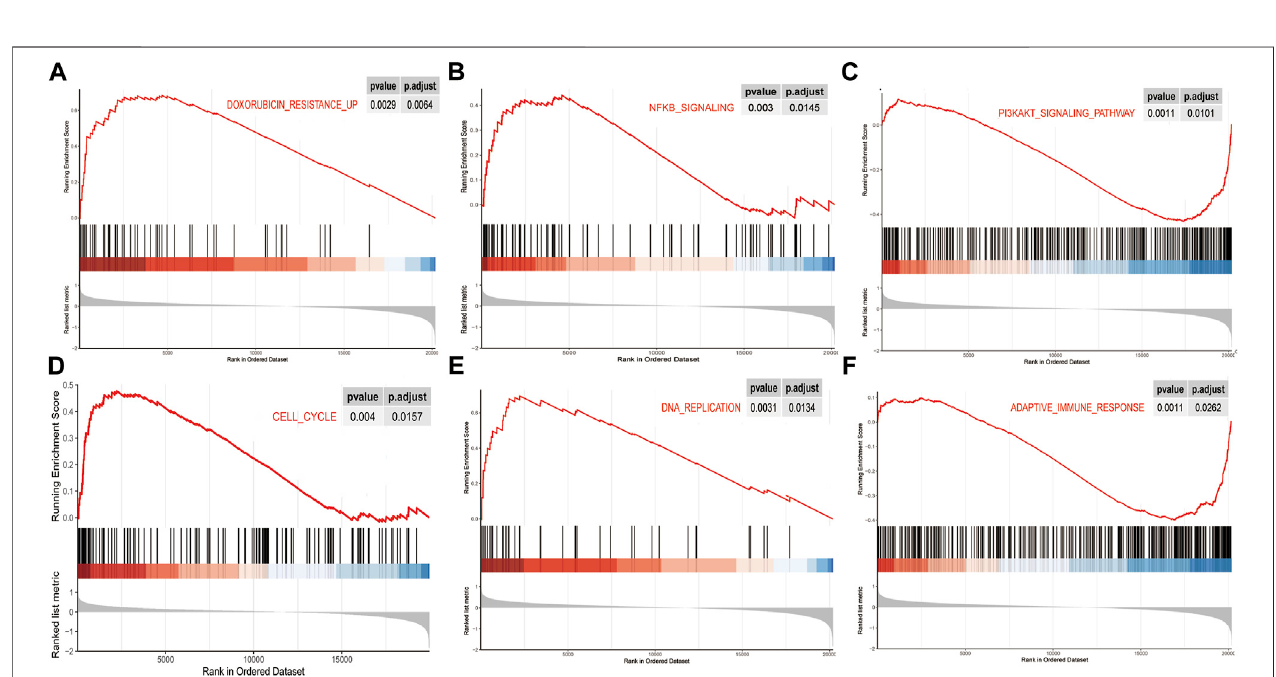
FIGURE 9 | Pathway characteristics of gene signature in DLBCL. (A-F) Gene set enrichment analysis revealed pathways enriched in the high-risk group and low- risk group.